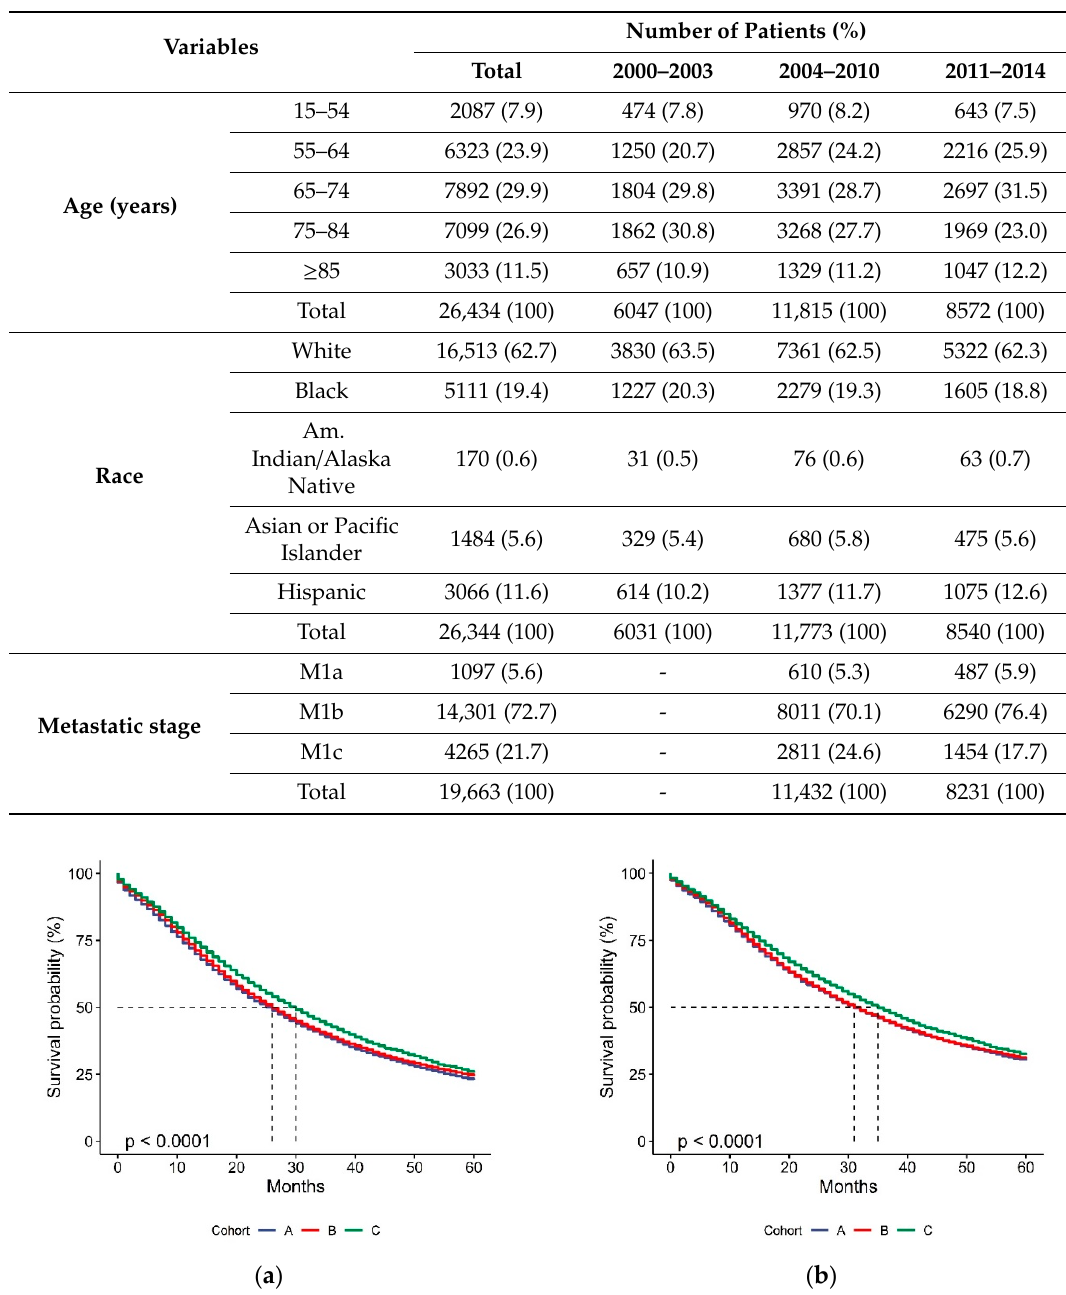
Figure 2. Kaplan–Meier estimations of overall survival (OS) ( a ) and cancer-specific survival (CSS) ( b ) according to cohort allocation. P-value from log-rank test.